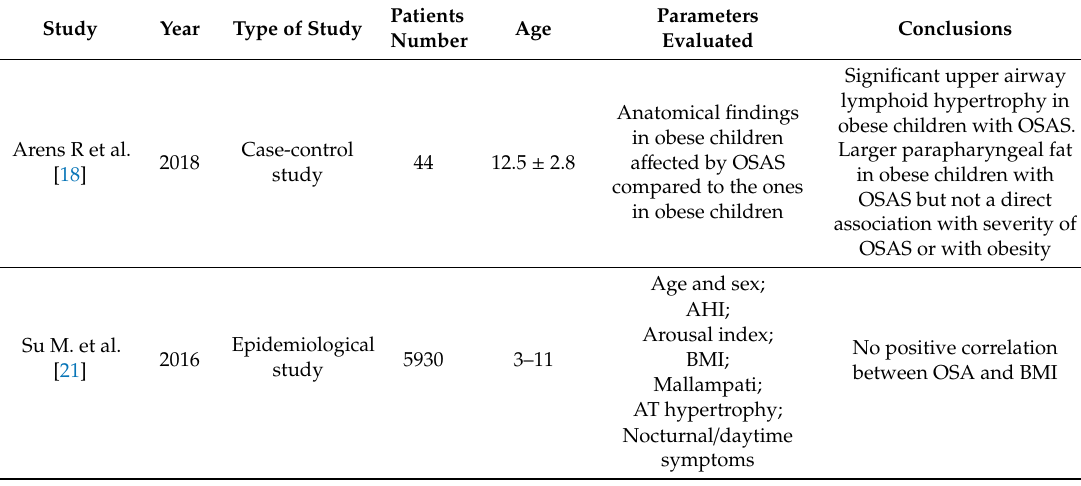
Table 1. Studies that have analyzed obesity as a pediatric OSA risk